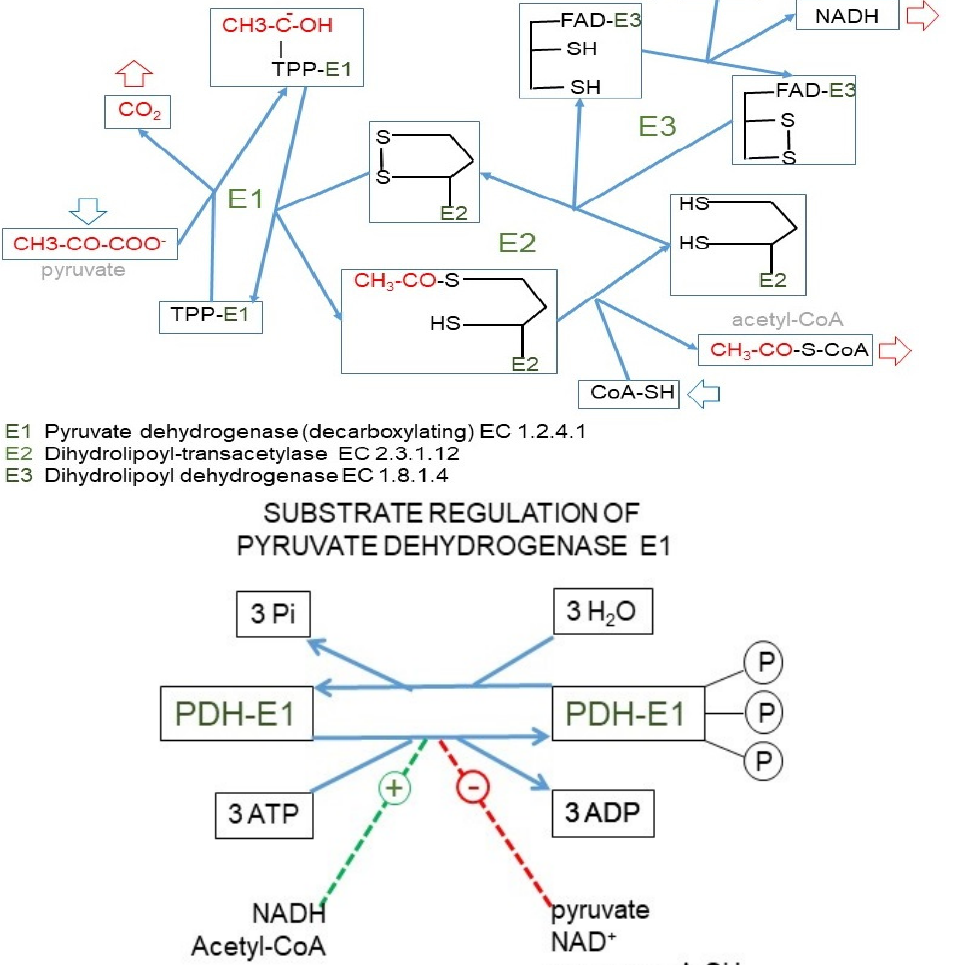
Figure 4. The pyruvate dehydrogenase complex. Upper panel: mechanism of action of the pyruvate dehydrogenase complex, showing why the reaction catalyzed by the E1 enzyme unit is irreversible. Lower panel: kinase/phosphatase regulation of the E1 subunit. Main factors regulating its activation/inhibition.